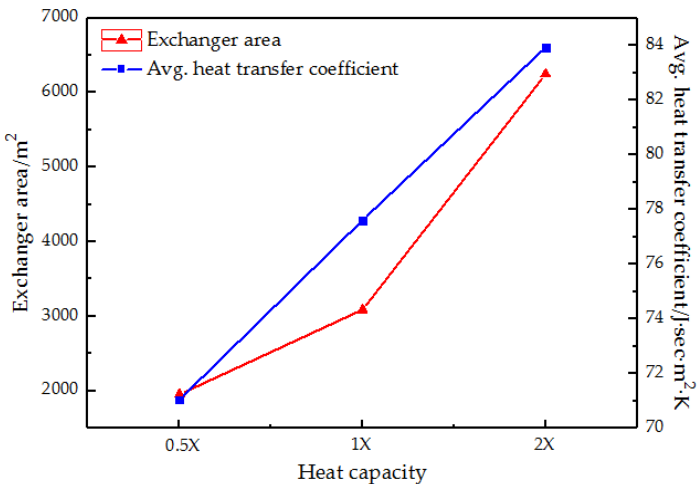
Figure 7. Effect of constant pressure heat capacity of [emim][Tf 2 N] on the heat transfer area and the average heat transfer coefficient of the heat exchanger. The red represents the exchanger area and the blue represents the average heat transfer coefficient.